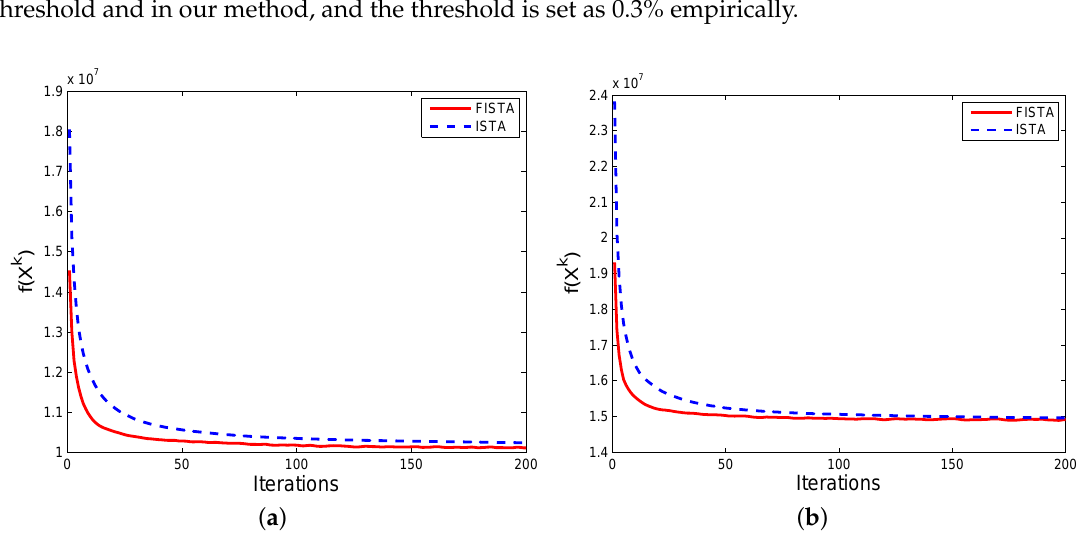
Figure 6. Convergence rate comparison between FISTA framework and previous variational model. (( a ) result on airplane_in_trees ; ( b ) result on Kaptein_01